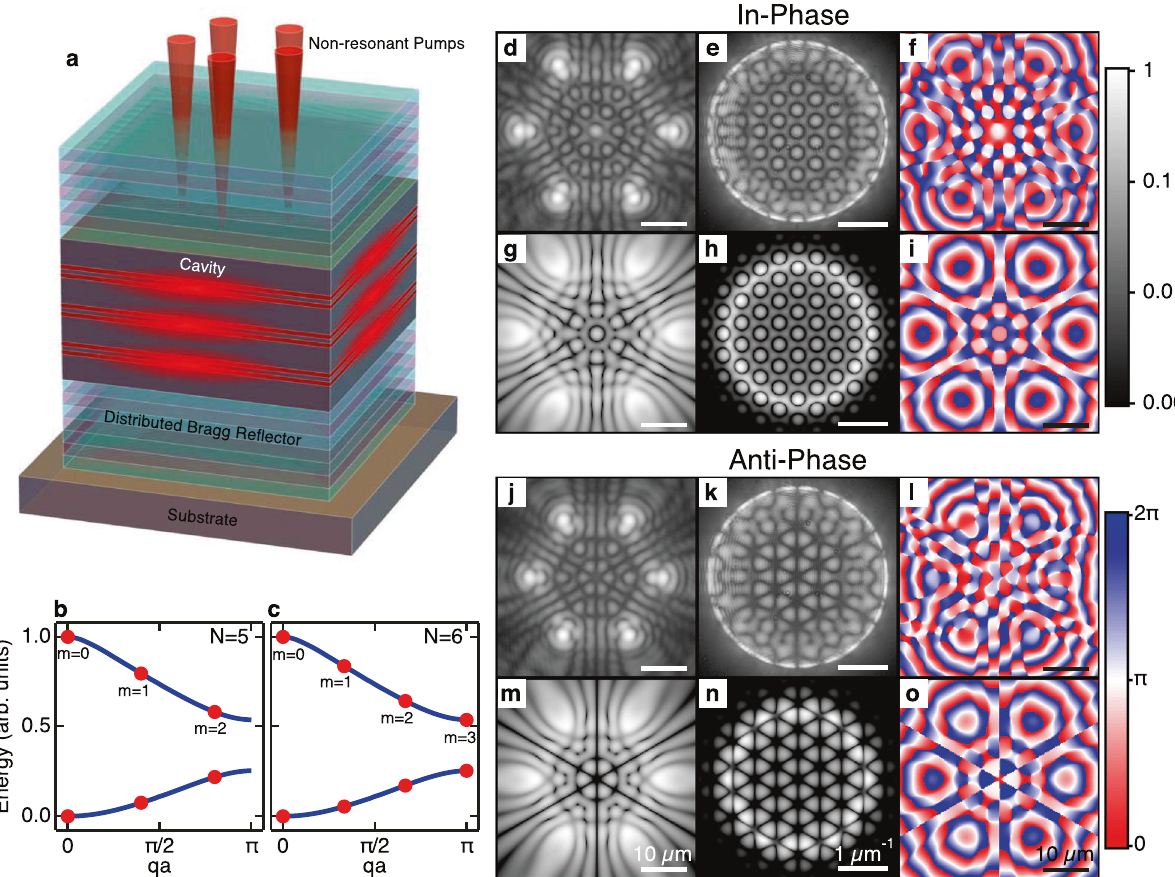
Fig. 1 Excitation schematic, Bloch modes, and stationary states in hexagons of polariton condensates. a Schematic showing a quantum well microcavity. Non-resonant lasers (red cones) at normal incidence create polariton condensates at their respective locations. b , c Example of reduced Brillouin zone energies of angular Bloch modes (red dots) in an N = 5 and N = 6 polygon, respectively. Blue curves show band structure in the thermodynamic limit. d , j Experimental condensate photoluminescence in real-space and e , k Fourier space in a hexagon geometry, with radii R = 16.9 μ m and R = 14.7 μ m, showing in-phase and anti-phase locked condensates, respectively. f , l Corresponding experimentally extracted real-space polariton phase maps. g – i and m – o show simulations of the steady-state polariton condensate wavefunction Ψ ( r , t ) using the driven-dissipative Gross – Pitaevskii equation in the in-phase and anti- phase locked con fi guration, respectively. g , m Real-space density ∣ Ψ ( r ) ∣ 2 , h , n Fourier-space density j ^ Ψ ð k Þj 2 , and i , o phase arg ð Ψ ð r ÞÞ . All real-space, Fourier- space, and phase images are plotted on the same scale de fi ned on the scale bar at the bottom of each